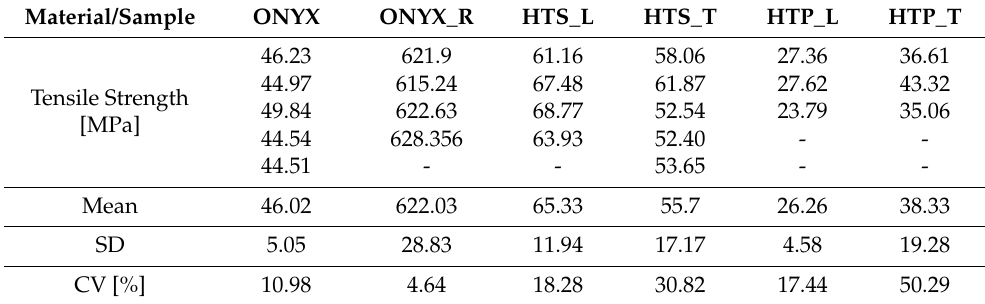
Table 6. Maximum tensile strength results.